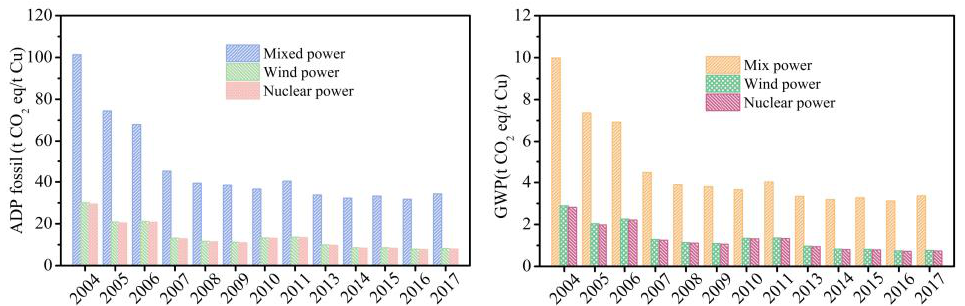
Figure 5. The impact of different electricity sources on the ADP fossil and GWP from 2004 to 2017.